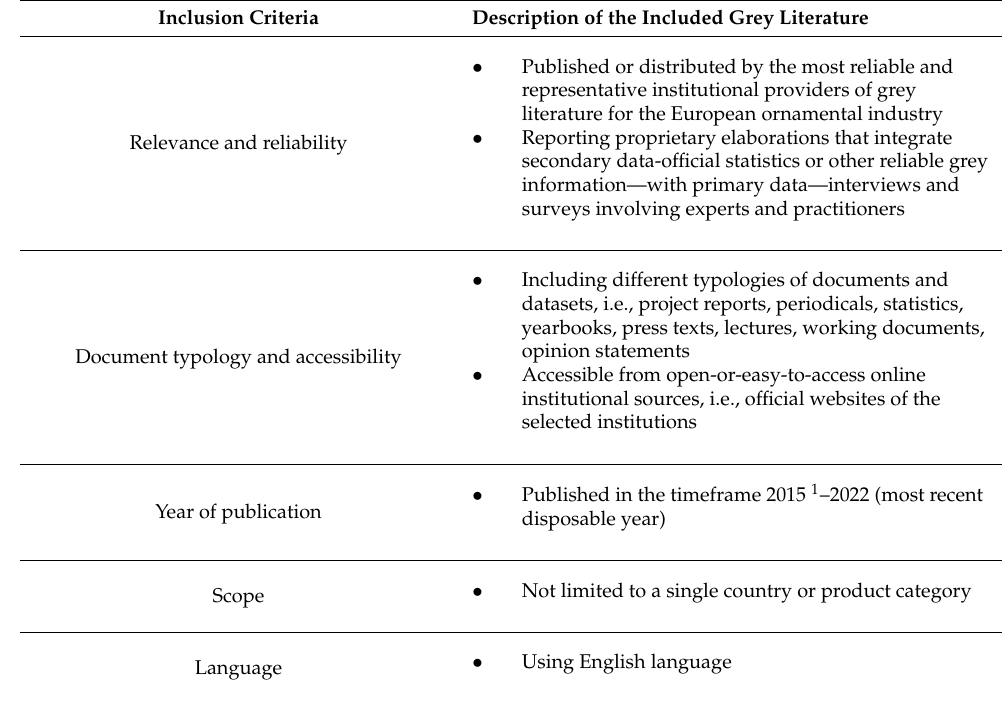
Table 3. Inclusion criteria and sample